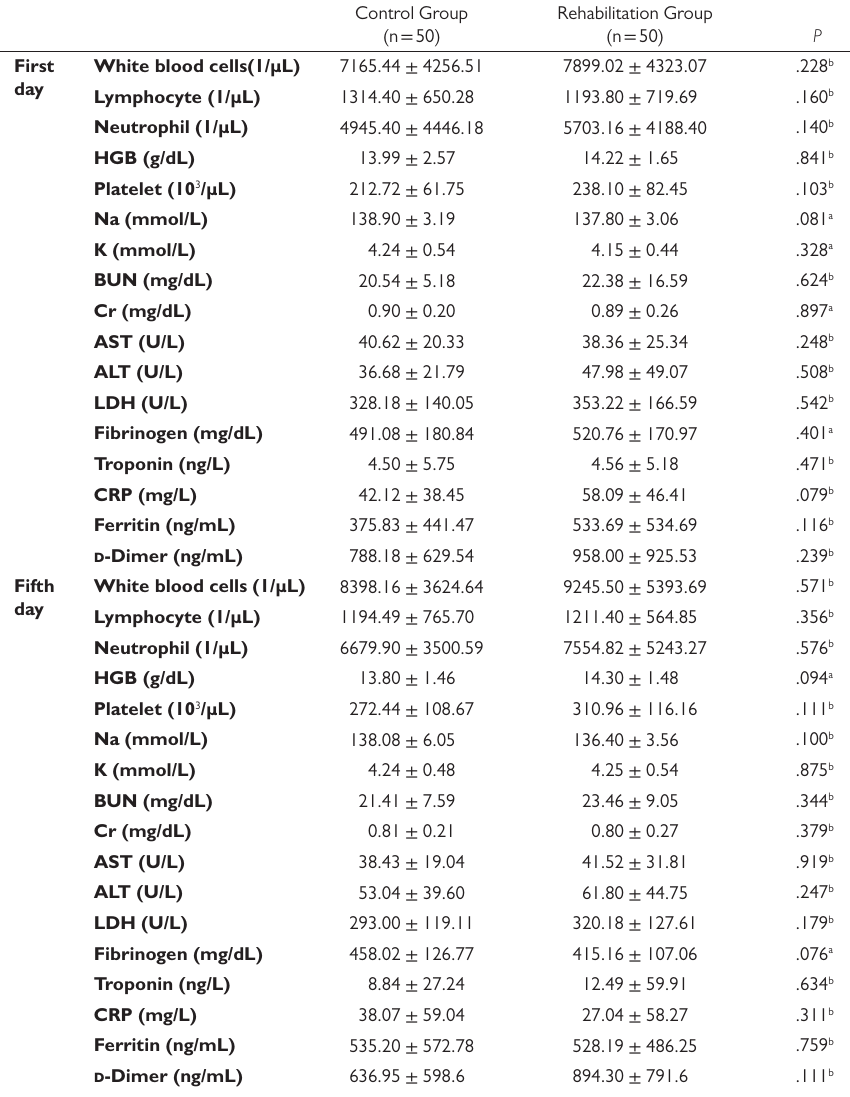
Table 2. Complete Blood Count and Biochemical Parameters in the Study